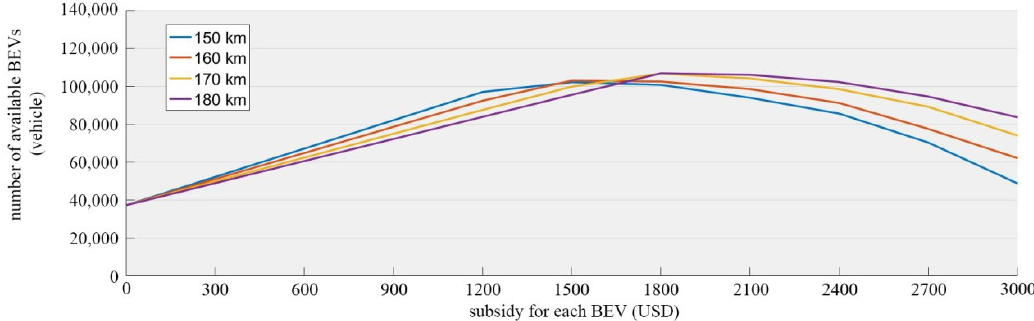
Figure 12. The results under different endurance ranges and subsidies.